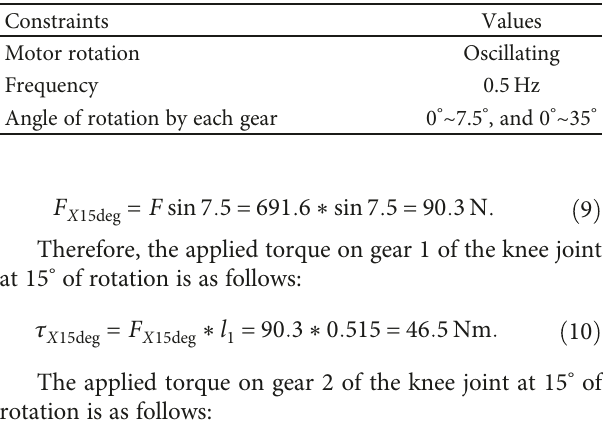
Figure 2: Free-body diagram of a prosthetic knee joint at di ff erent phases of the gait cycle. Table 2: Boundary conditions of the knee joint